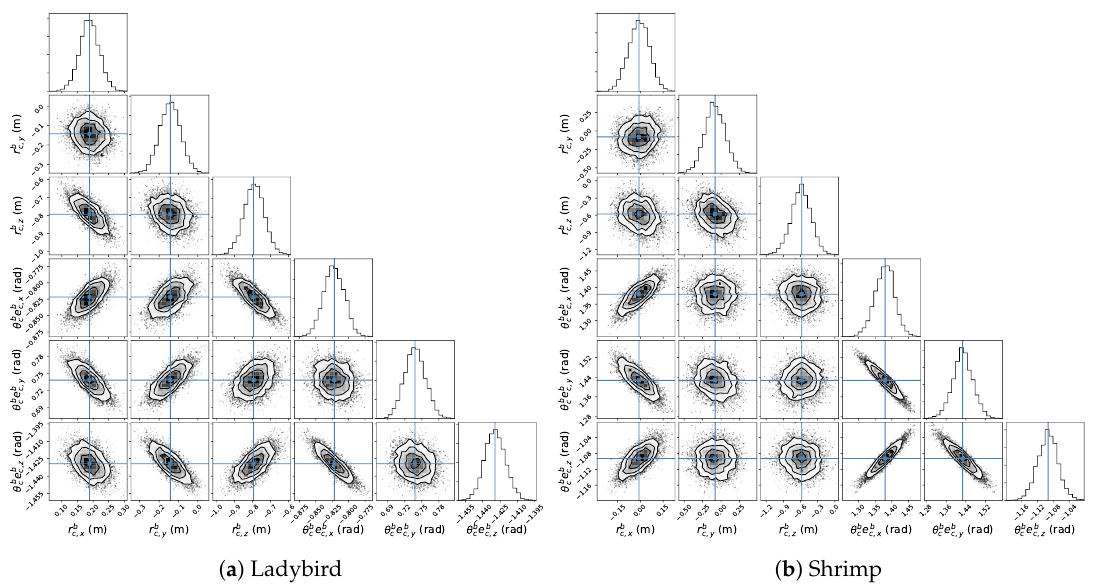
Figure 10. Corner plots for ( a ) Ladybird and ( b ) Shrimp platforms for 16 and 14 observations respectively. Each sub-plot below the diagonal provides a 2D histogram of MCMC sample values for a pair of relative camera pose parameters. The sub-plots on the diagonal show 1D histograms for each